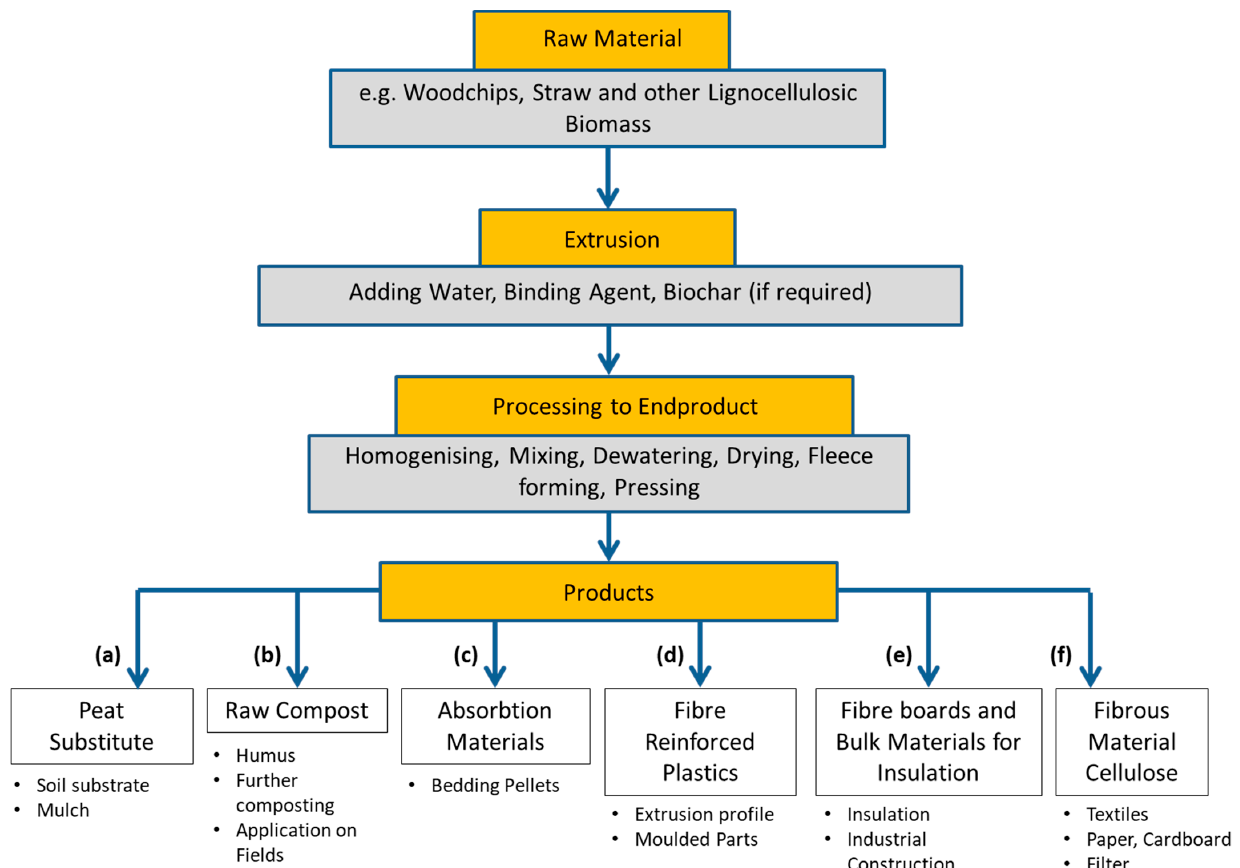
Figure 1. Processing steps and application of extruded wood fibre